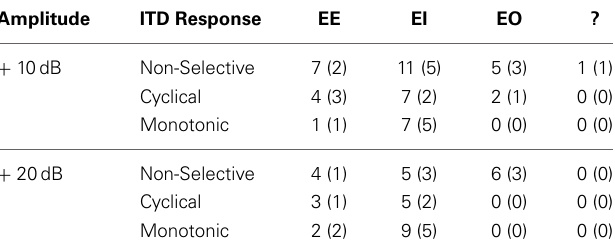
Table 6 | Binaural interactions of IC neurons with different types of ITD response